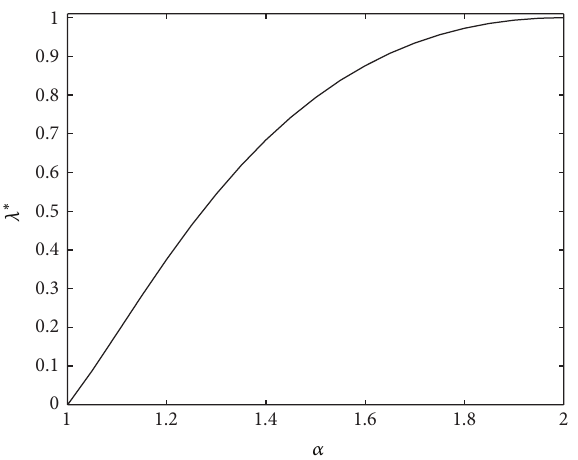
Figure 7: Curve of 𝜆 ∗ versus 𝛼 for 𝑐 = 1 .